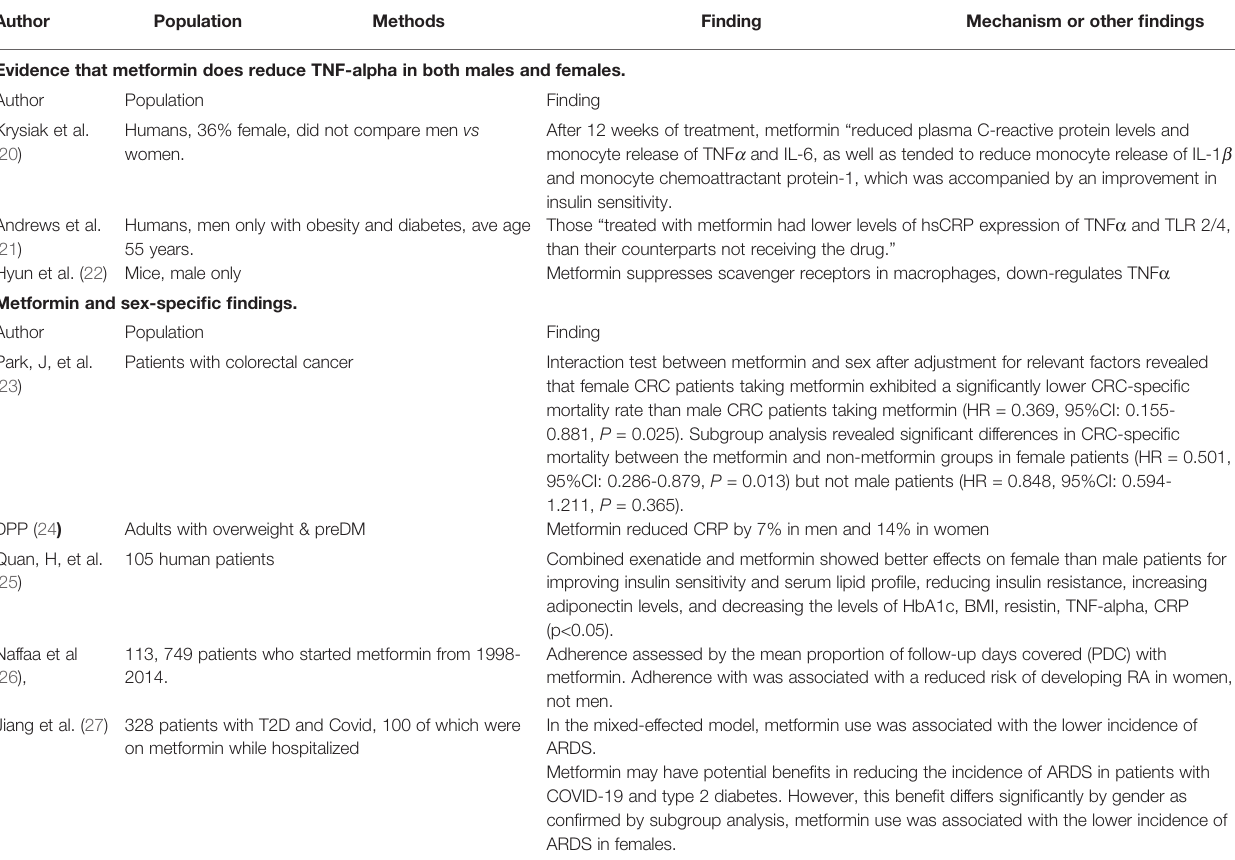
fi brosis via activation of lung myo fi broblasts (41, 69). Pulmonary fi brosis has been noted in persons with Covid-19, speci fi cally in those with elevated IL-6 levels